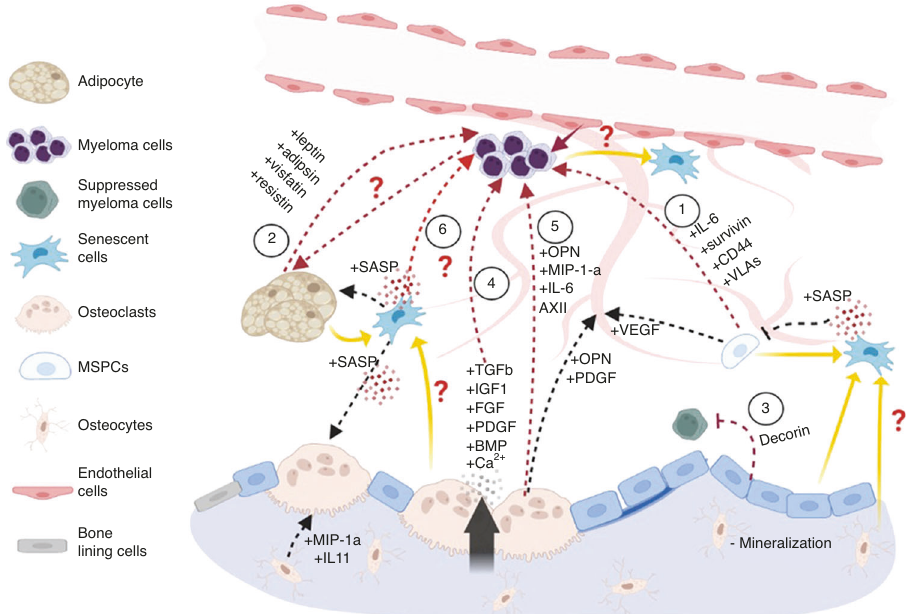
Fig. 6 Crosstalk between the components of aged bone and age-associated multiple myeloma. Multiple myeloma is an age-associated disease that is closely related with bone cells. Myeloma cells establish a tumor microenvironment with osteoblastic and osteoclastic cells and generation of bone matrix, which creates a vicious cycle that promotes myeloma cell expansion on bone lesions. The contribution of bone cells and senescent cells under aging conditions to the tumor microenvironment and maintenance of myeloma cells are described as follows: (1) Most cell compartments in the tumor microenvironment, except the osteoblast compartment, support tumors. Mesenchymal progenitors directly promote the proliferation, migration, and adhesion of myeloma cells through the action IL-6, survivin, CD44, VLAs, syndecan 1 and MCP-1 or indirectly affect myeloma cells through osteoclastogenesis and angiogenesis. (2) An increase in the number of adipocytes support MM through their release of adipokines, such as leptin, adipsin, visfatin and resistin. (3) Osteoblasts have been identi fi ed as the only cells that inhibit myeloma cells through Decorin. (4) However, osteoblasts indirectly promote myeloma cells through the activation of osteoclasts. Osteoclasts resorb bone matrix, release numerous tumorigenic factors, such as TGF- β , IGF-1, FGF, PDGFs and BMPs, and increase the extracellular calcium level. (5) The direct mechanism by which osteoclasts affect myeloma cells involves the secretion of soluble factors, such as osteopontin, MIP-1a, IL-6, Annexin II, BAFF and APRIL. Although senescent mesenchymal progenitors and adipocytes have been reported in MM, the mechanisms underlying their senescence are still not clear, particularly in the early stages of MM. (6) In MM, an increased number of senescent cells in the tumor environment has been observed, but the contribution of increased senescent cells remains unclear. Senescent cells inhibit osteoblast differentiation but promote osteoclast differentiation through SASP